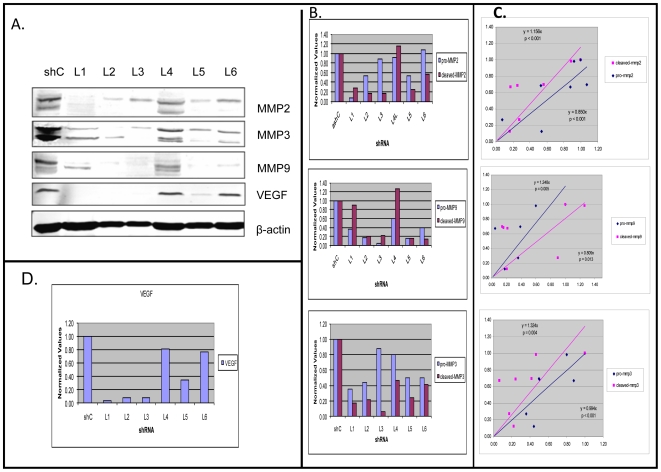

DSPP-silencing downregulates SIBLING-partnering MMPs in OSC2 cells.(A) WB and (B) corresponding densitometric analyses show significant down-regulation of pro- and activated MMP-2, MMP-3, and MMP-9 in all but one (L4) of the six DSPP-silenced stable lines. (C) Least square regression analyses show significantly reduced levels of pro-and activated MMP-2 {(y = 0.850x, p<0.001) (y = 1.156x, p<0.001)}; MMP-3 {(y = 0.0.994x, p<0.001) (y = 1.324x, p = 0.004)}, and MMP-9 {(y = 1.248x, p = 0.005, y = 0.809, p = 0.013)}, and a direct correlation between the degree of DSPP-silencing and MMP suppression; however, the level of MMP suppression did not differ significantly between pro- and cleaved forms. (D) Densitometric analysis of WB of VEGF levels showed down-regulation ranging from <5% (L4) to 86% (L2) with the level of down-regulation directly proportional to the degree of DSPP-silencing.